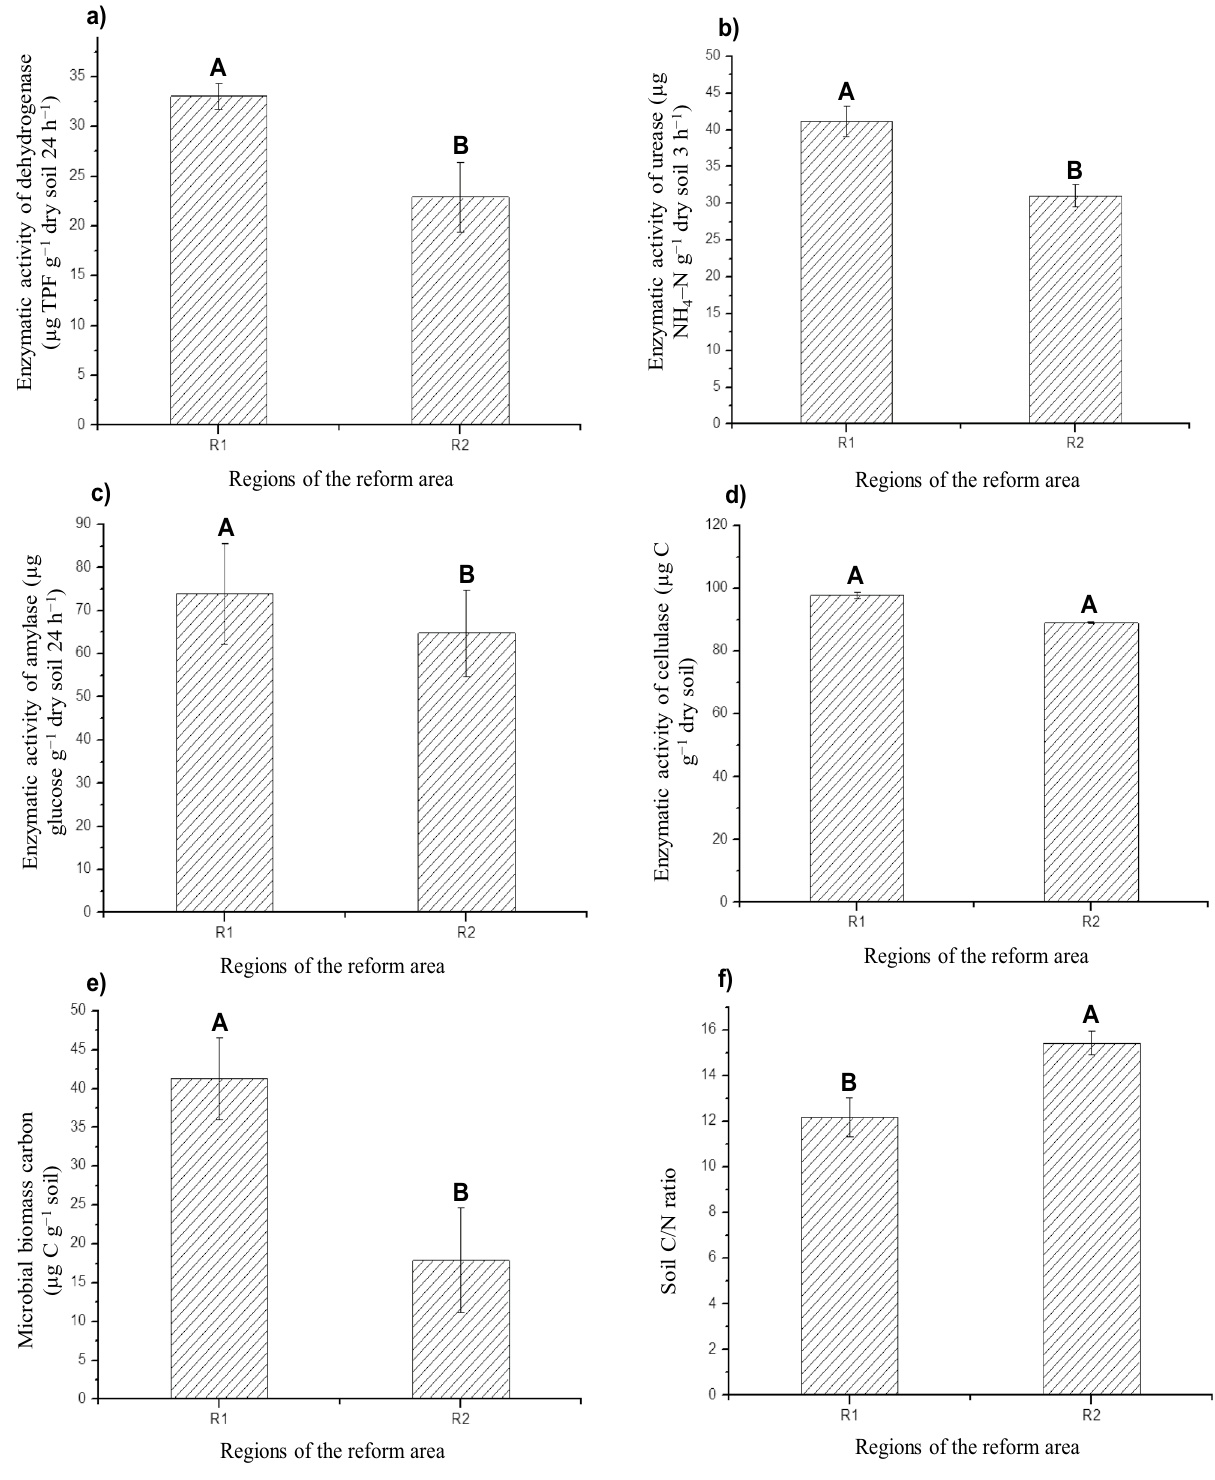
Figure 3. Mean ± standard error of the mean of the enzyme activity of dehydrogenase ( a ), urease ( b ), amylase ( c ), and cellulase ( d ), microbial biomass carbon ( e ), and soil C/N ratio ( f ) in both regions (R1 and R2) of the field reform area. Means followed by the same letter do not differ from each other by the Student’s t test (p <